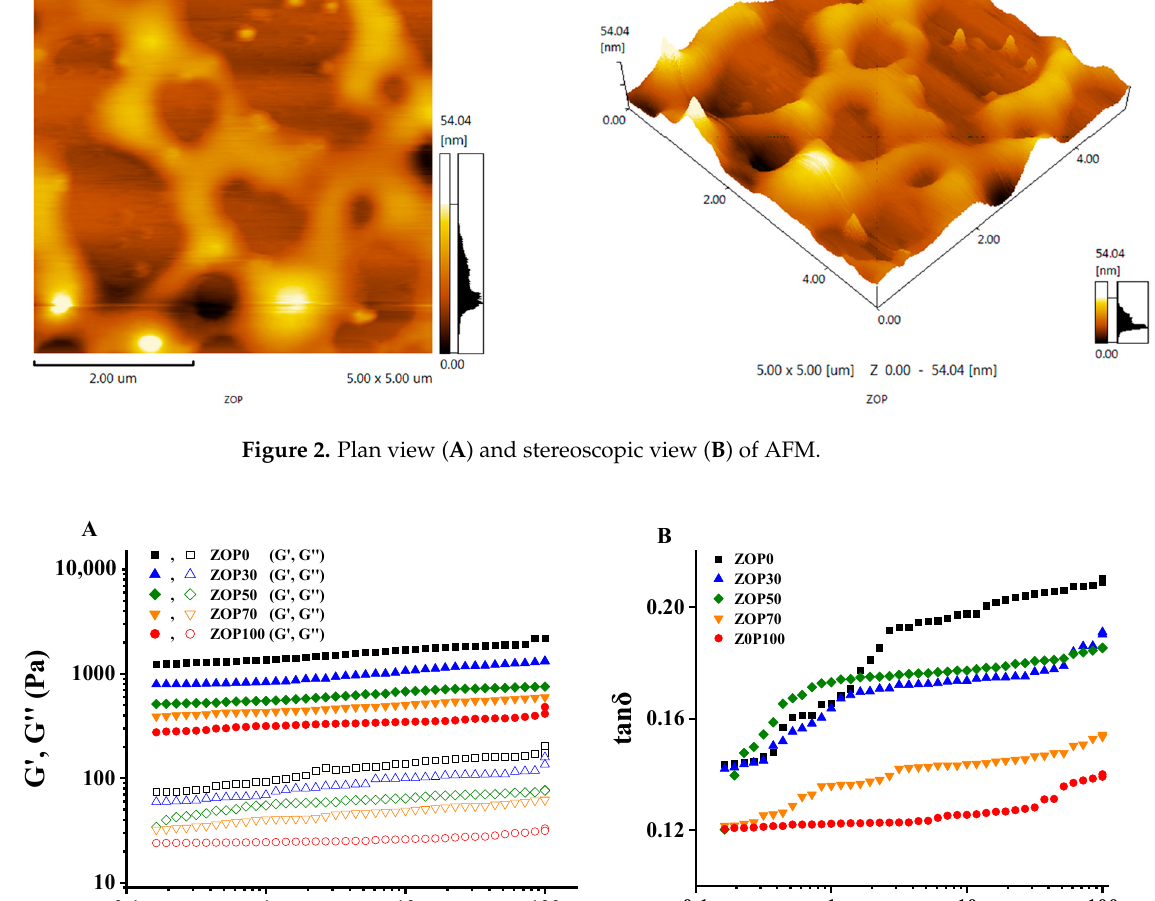
Figure 2. Plan view ( A ) and stereoscopic view ( B ) of AFM.